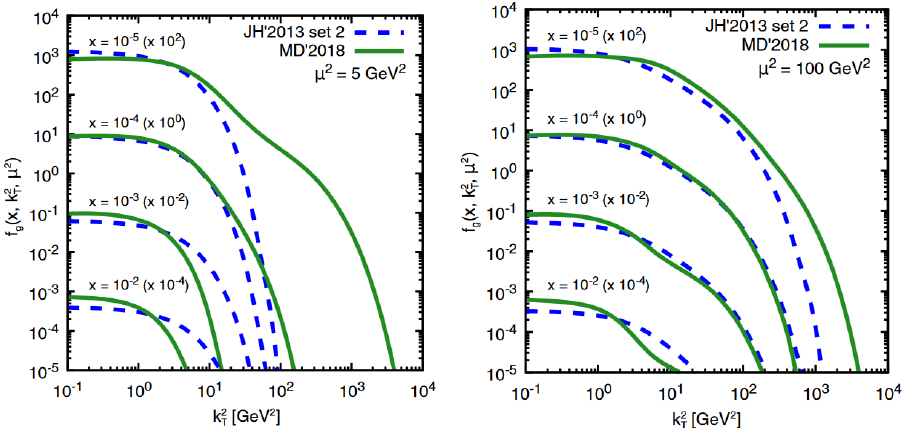
Figure 2. The TMD gluon densities in the proton calculated as function of the gluon transverse momentum k 2 at different longitudinal momentum fraction x and µ 2 values. The T green (solid) and blue (dashed) curves correspond to the MD’2018 and JH’2013 set 2 gluon density functions,